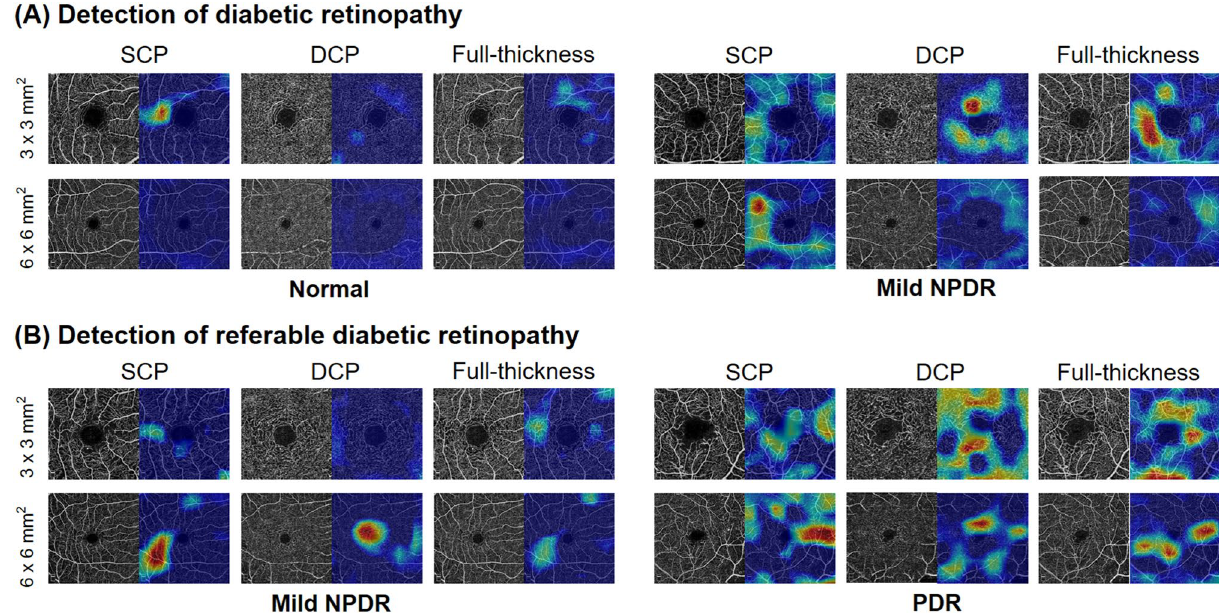
Figure 2. Representative Class activation map (CAM) images highlighting pathologic regions, shown in pairs of original optical coherence tomography angiography (OCTA) images (left) and corresponding CAM overlaid on the original images (right) of representative cases. CAM images were generated using the superficial capillary plexus, deep capillary plexus, and full-thickness retinal slabs from 3 × 3 mm 2 to 6 × 6 mm 2 macular OCTA scans. ( A ) CAM images of normal (left) and mild non-proliferative DR (right) cases for DR detection, accompanied by the corresponding original image. ( B ) CAM images of mild non-proliferative DR (left) and proliferative DR (right) for referable DR detection, accompanied by the corresponding original image. This figure was created using Photoscape (http:// photo scape. co. kr/ ps/ main/ index.